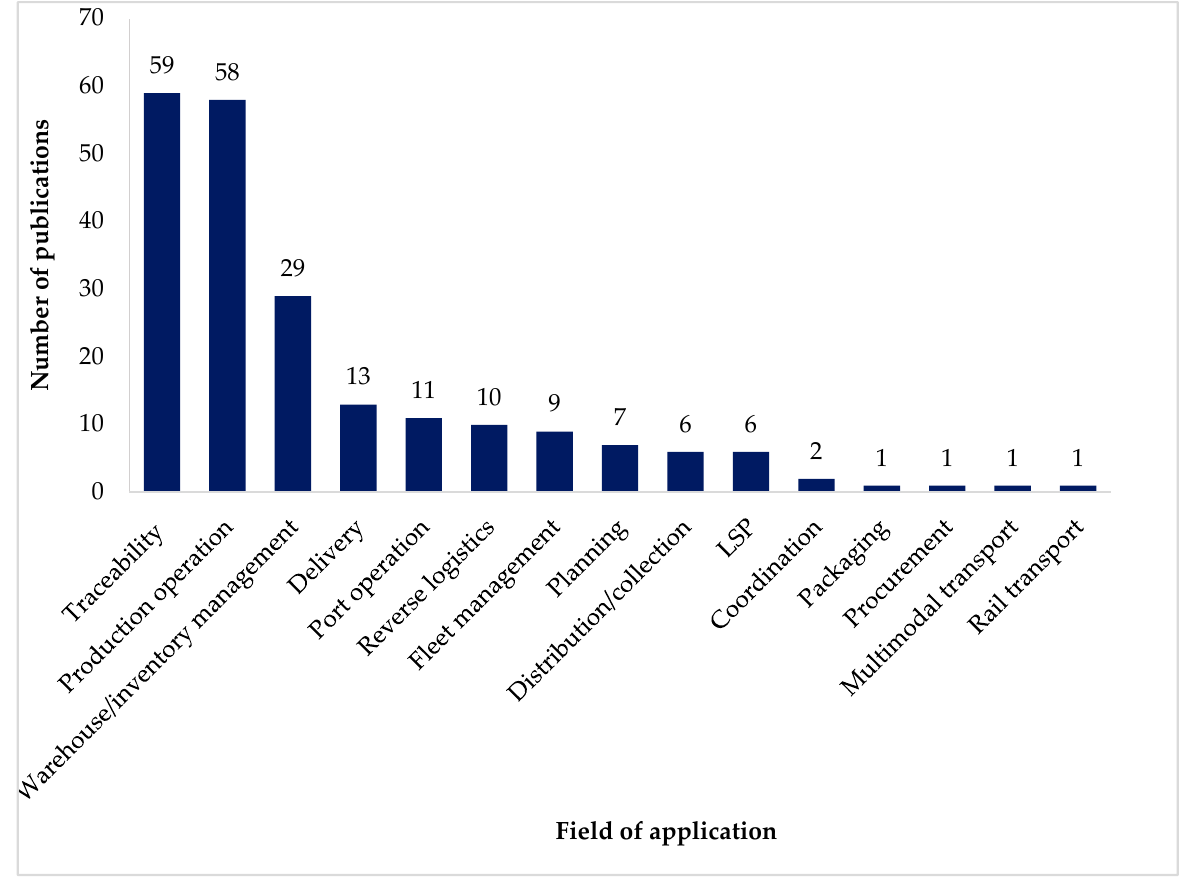
Figure 7. Distribution of the papers reviewed based on field of application. LSP = logistics service providers.